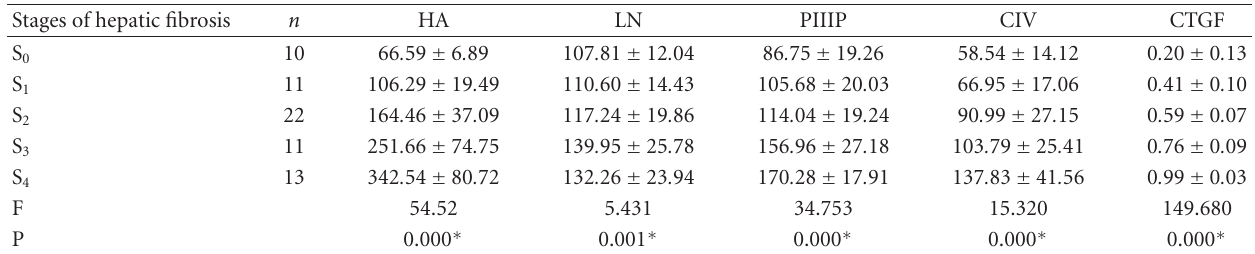
Table 1: Results of related indices in di ff erent stages (mean ± SD).